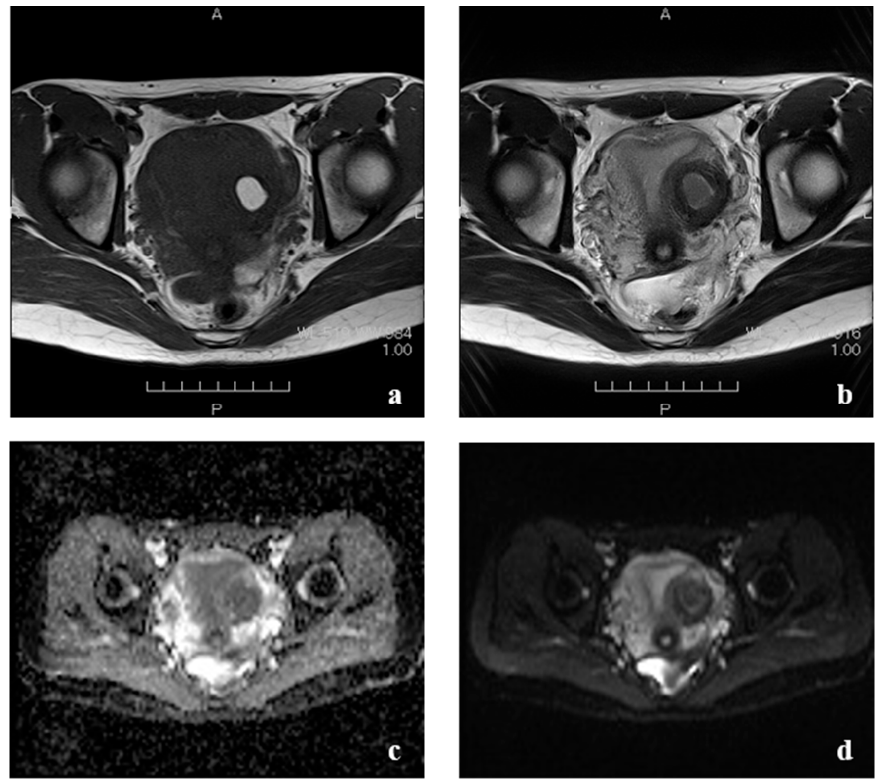
Figure 3. Pelvic magnetic resonance imaging. ( a ) T1-weighted image showing a hyperintense cyst in the left side of the uterus. ( b ) T2-weighted image showing a normal uterine cavity and a hypointense lesion in the left side of the myometrium. ( c ) The cyst did not show any diffusion restriction on diffusion-weighted images. ( d ) Apparent Diffusion Coefficient Map.